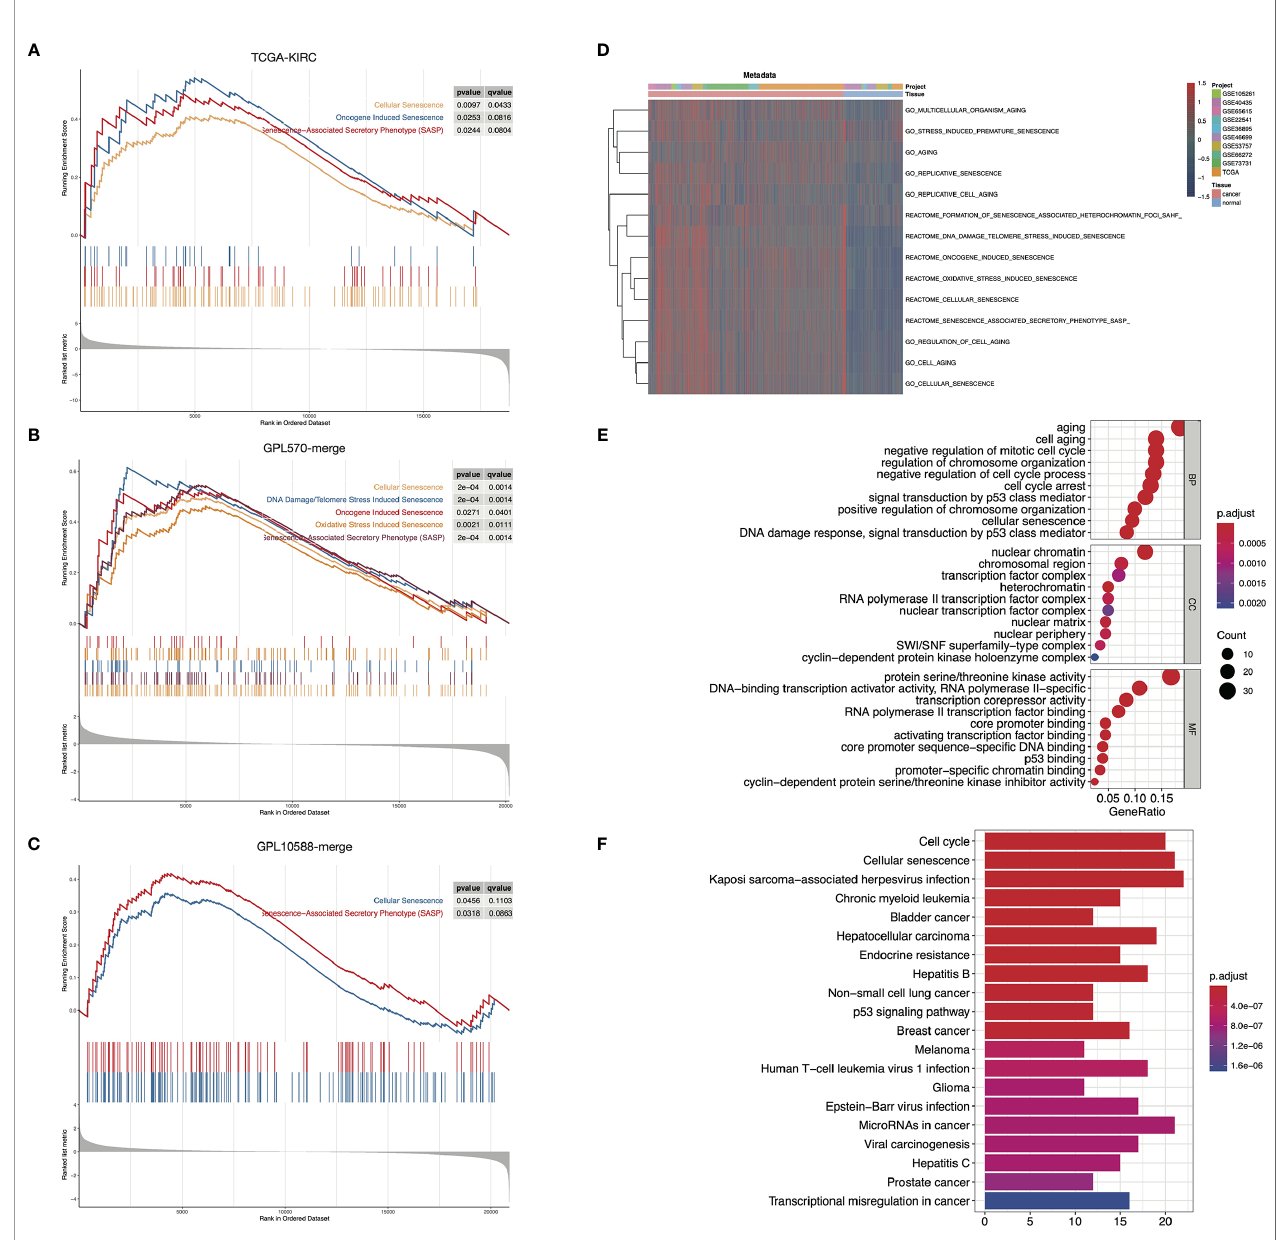
FIGURE 1 | Senescence-related biological processes were highly activated in ccRCC. (A – C) GSEA results showed that senescence-related biological processes were activated in ccRCC tumor samples in TCGA-KIRC (A) , GPL570-merge (B) , and GPL10588-merge (C) datasets. (D) Senescence-related biological processes were generally activated in ccRCC tumor samples in the metadata set. The biological process activity was assessed using the “ GSVA ” package. (E, F) Functional annotation of the 204 DESGs in the GO (E) and KEGG (F)